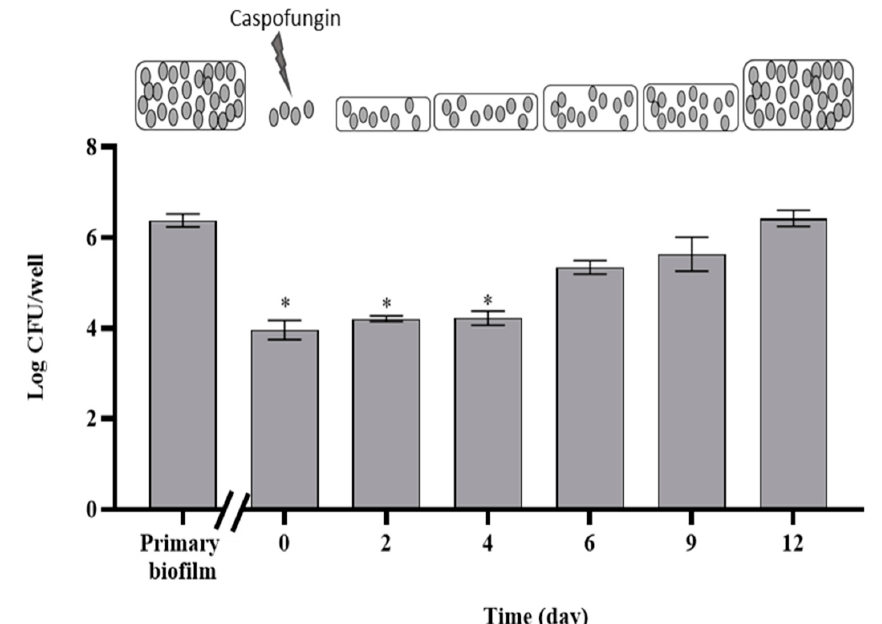
Figure 4. Development of a new biofilm from persisters. Viable cells increase during development of the biofilm derived from cells of the primary biofilm survived at caspofungin treatment (persisters) at time = 0. On the top, a schematic representation of the development of the persister-derived biofilm. * represent significant difference vs. primary biofilm, p < 0.05 (Holm–Sidak’s